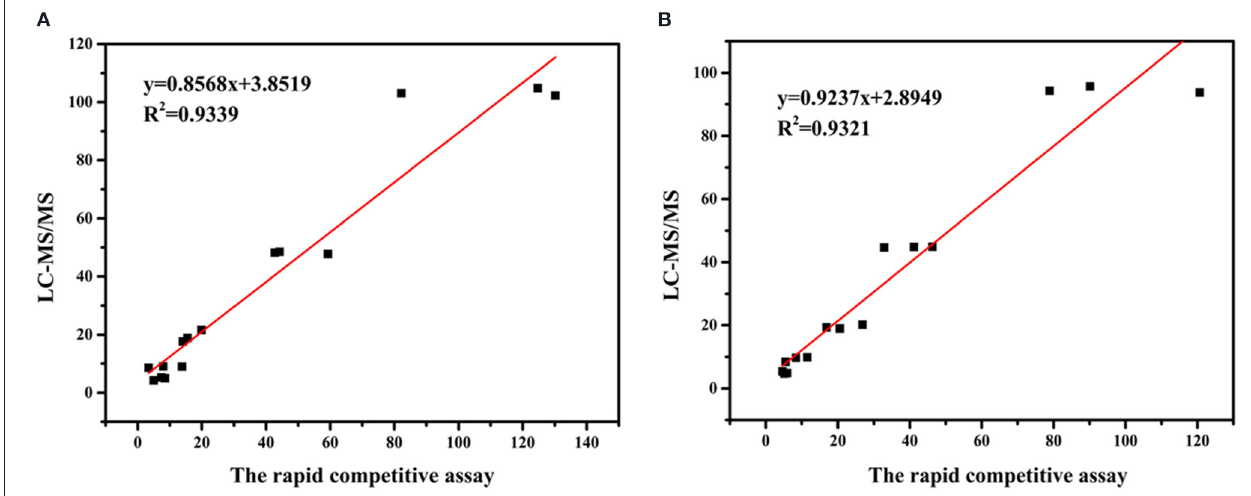
FIGURE 6 | Correlation between the concentrations of CBZ measured by the proposed competitive assay based on Au@Pt-dsDNA-Fe 3 O 4 mediated biosensor and LC–MS/MS in (A) leeks and (B) rice.